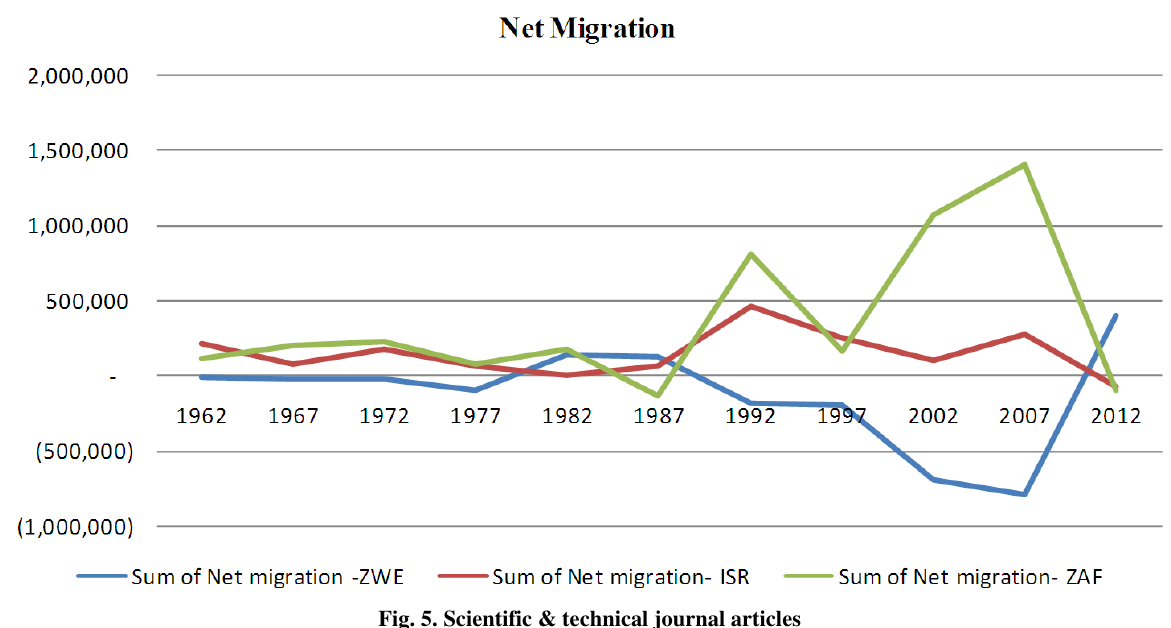
Fig. 5. Scientific & technical journal articles Source: based on the World Bank (2015) World Development Indicators